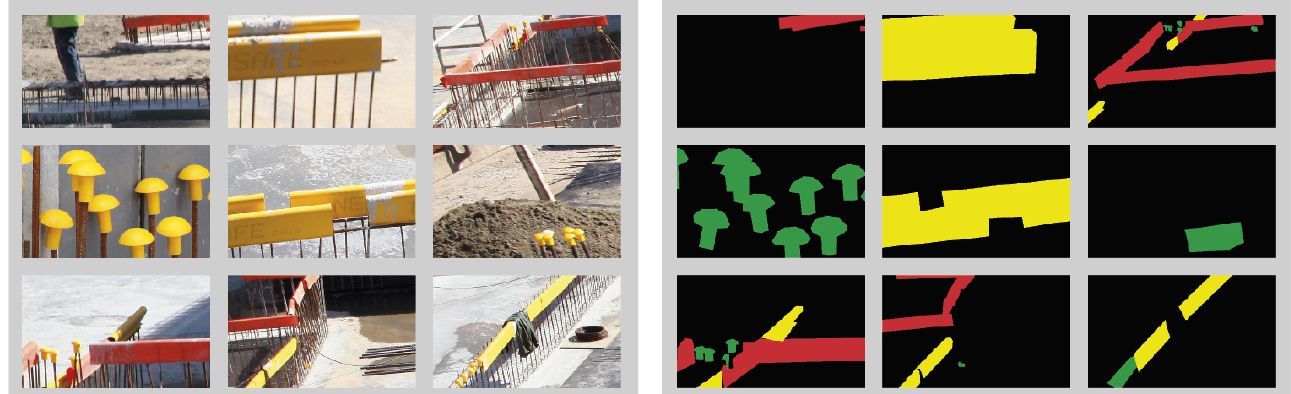
Figure 4. Example of training data: original input images ( left ) and ground-truth semantic labels of rebar covers ( right ).